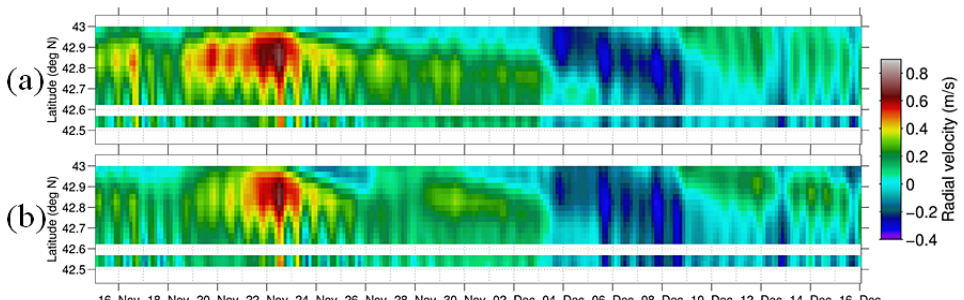
Figure 11. Hovmöller diagram of radial velocities from the PEY station along a south–north transect at 6.2 ◦ N (see Fig. 1) (a) from WindReal and (b) ObcReal